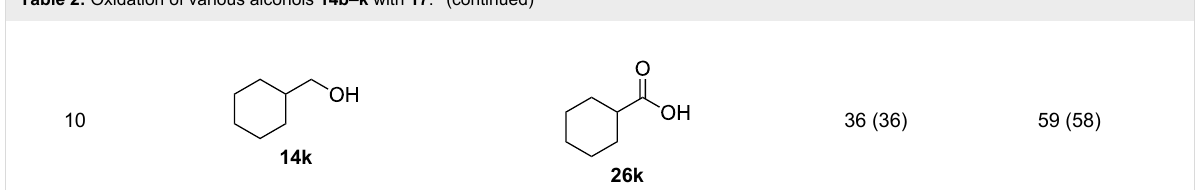
Table 2: Oxidation of various alcohols 14b – k with 17 . a (continued)